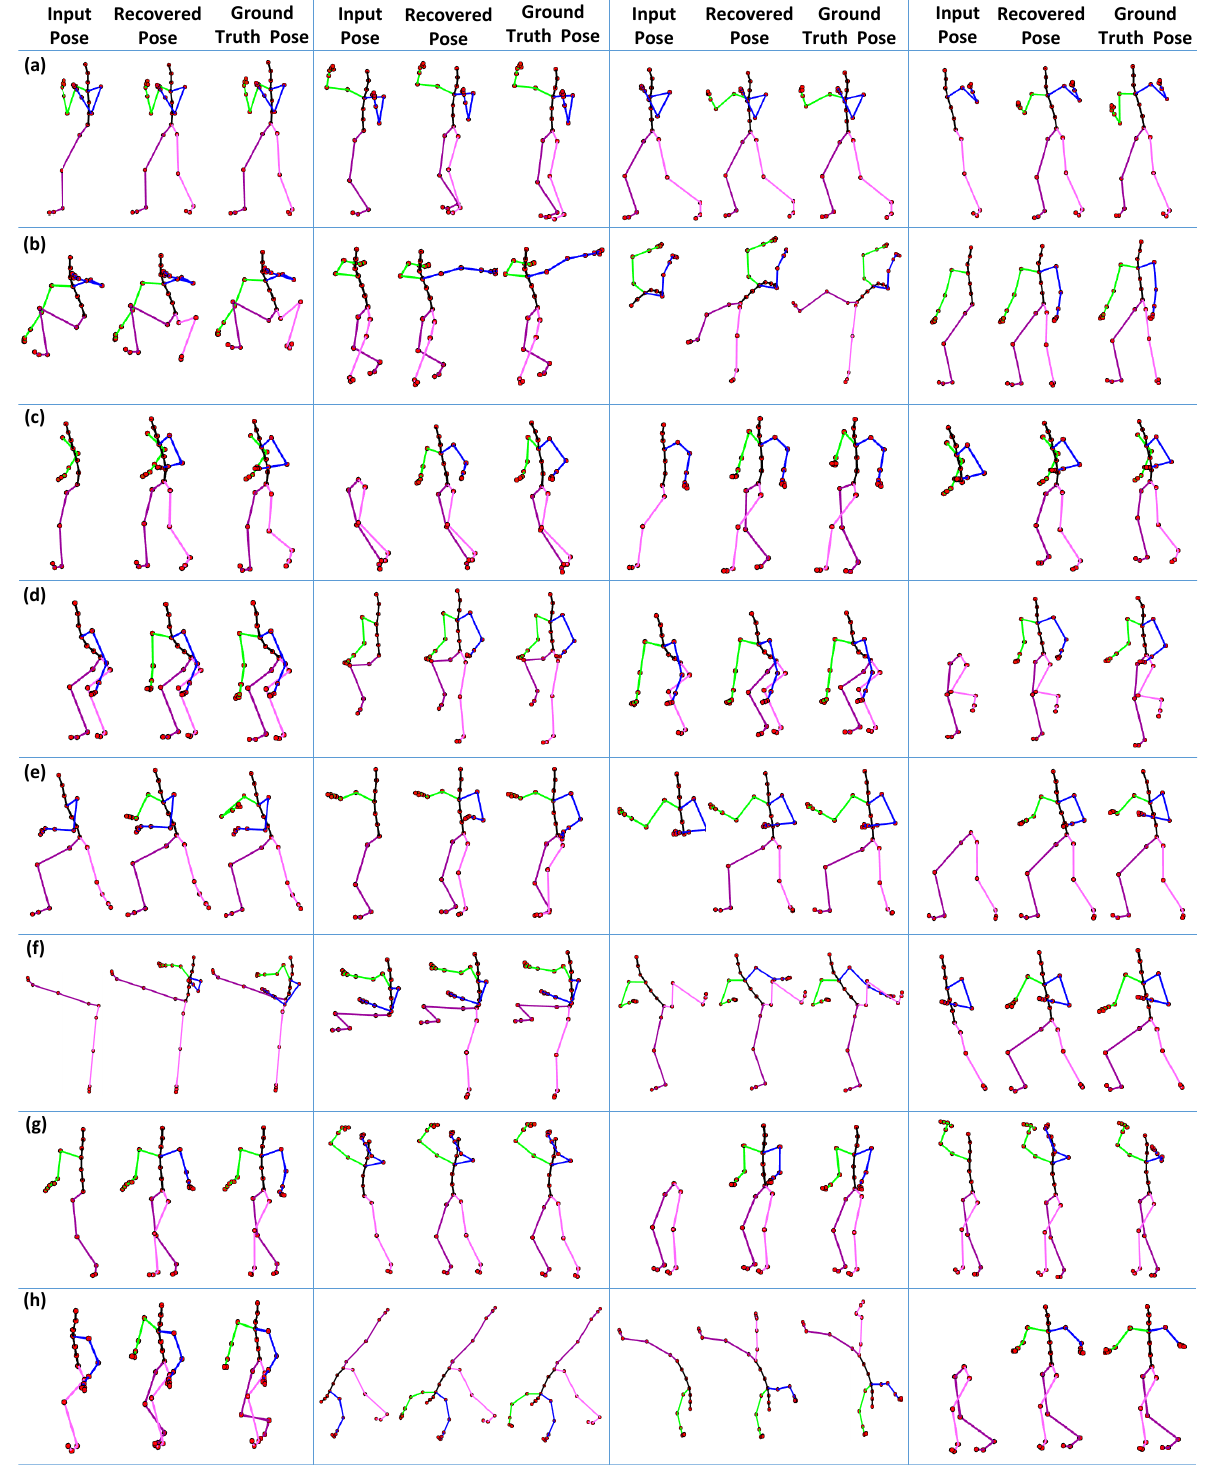
Figure 17. The 3D recovery results for different motion categories when missing a whole body part. ( a ) Boxing; ( b ) Jumptwist; ( c ) Run fig8; ( d ) Jumping; ( e ) Martial Arts; ( f ) Kicking; ( g )